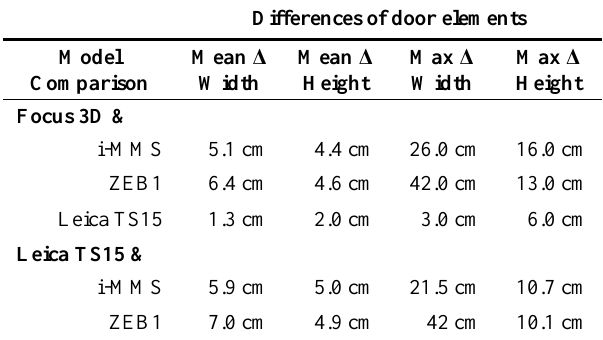
Table 3: Differences based on 10 door elements